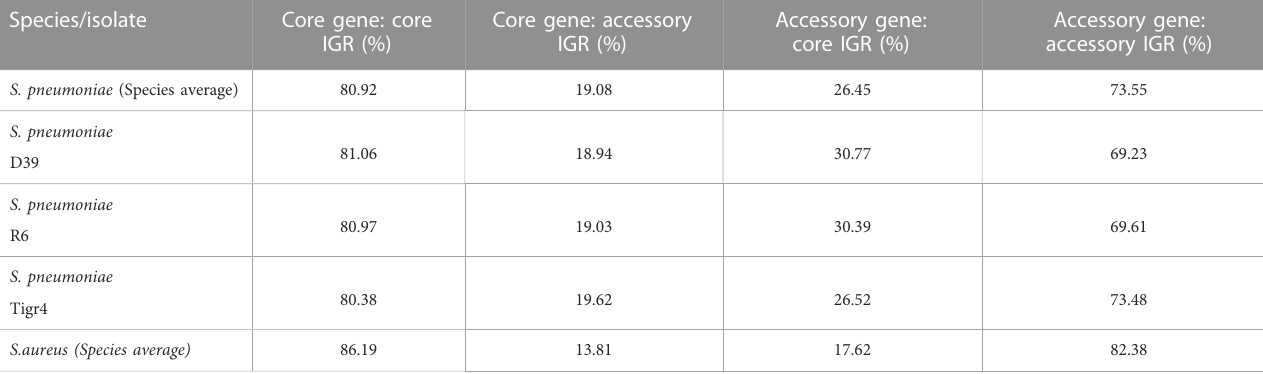
TABLE2Genes andtheirupstreamIGRwasanalyzedfortheirdistribution inthepangenome.Listedarethe percentage coreand/orgeneswithacoreand/oraccessory IGR immediately upstream.